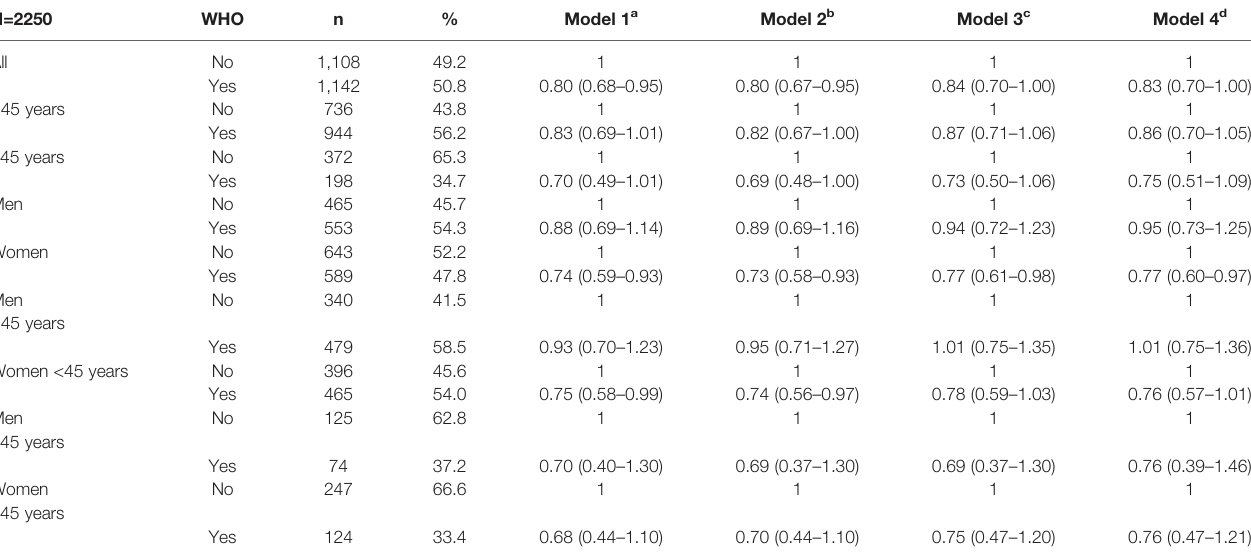
TABLE 3 | Adjusted odds ratios (95% con fi dence interval) for current perceived worse mood in relation to WHO physical activity guidelines (reference: less than 150 weekly minutes of physical activity) in the entire study population and in age and gender subgroups.